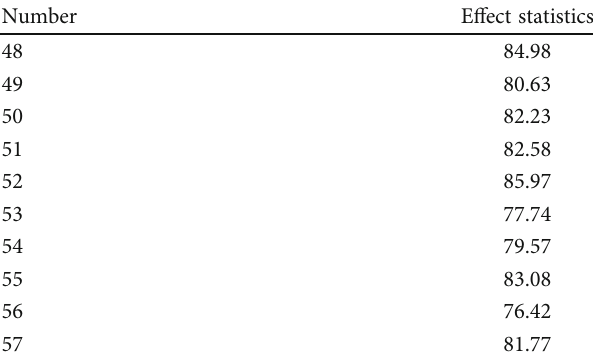
Table 1: Validation of talent training e ff ect of the experimental teaching model of electrical courses considering various constraint models and knowledge recognition